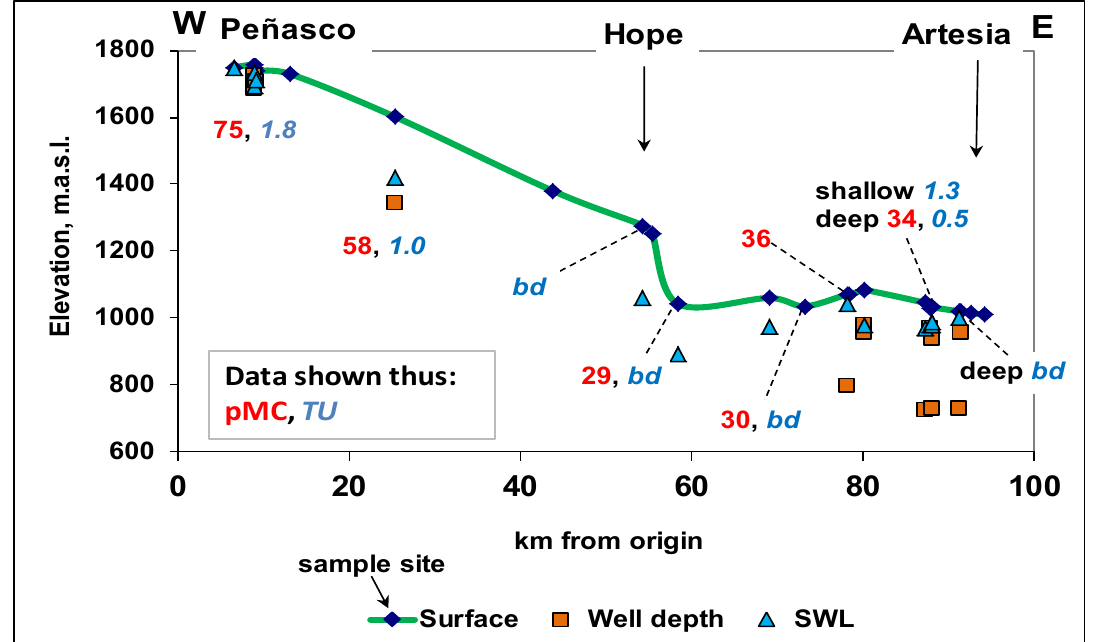
Figure 8. A. East-west profile of Area 2 (refer to Figure 2 for location) showing well depths and static water levels (SWL) in relation to the surface. “Shallow” refers to the shallow aquifer at Artesia, and “deep” to the deeper artesian aquifer. Also shown are measurements of carbon-14 (pMC) and tritium (TU). Tritium below detection is indicated as